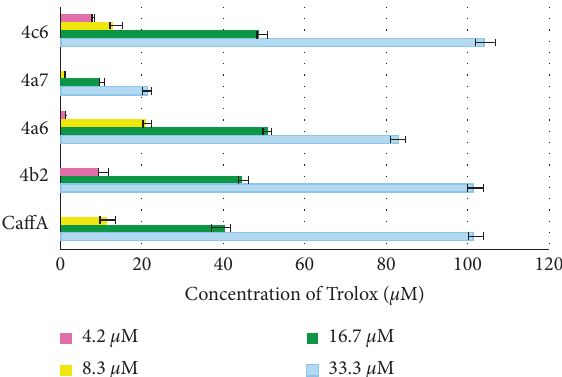
Figure 4: Cupric reducing antioxidant capacity (CUPRAC) of the tested substances applied in diferent concentrations (from 4 to 33 µ M) and expressed as the Trolox